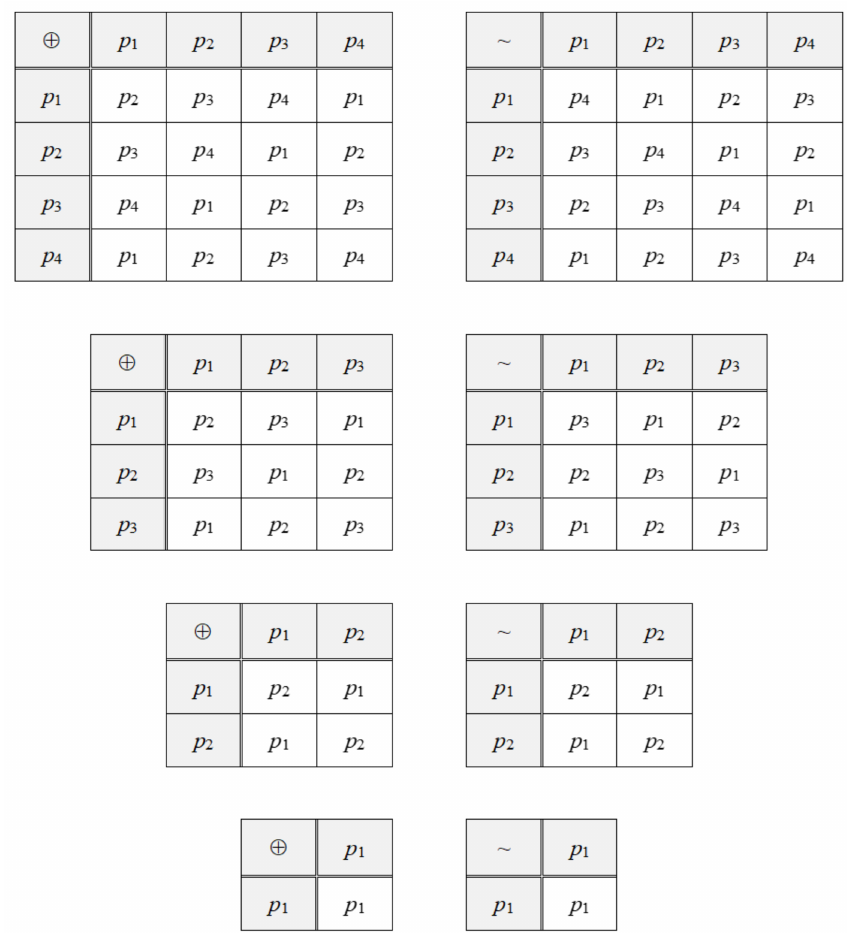
Figure A1. Addition and subtraction operations of